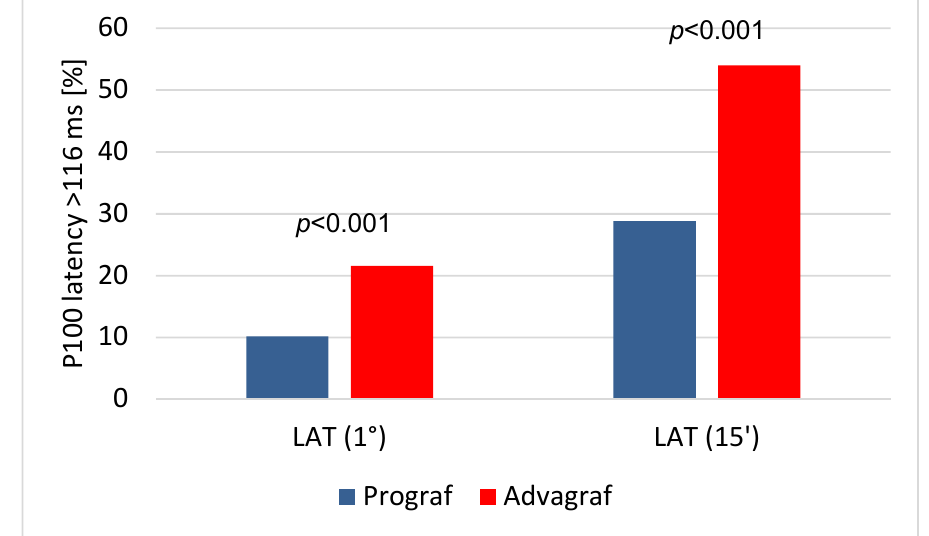
Figure 1. Results of the pattern visual evoked potentials (VEP) examination. The percentage of eyes with prolonged P100 latency (1°) ( A ) and latency (15′) ( B ) duration (with laboratory normal value ≤ 116 ms) in patients treated with Prograf (blue bars) and Advagraf (red bars). Table 2. Results of pattern and flash VEP examinations in the eyes of kidney transplant recipients treated with two different tacrolimus formulations. Prograf Advagraf Statistics n = 59 n = 70 Pattern VEP examination—P100 parameters Latency (1°) (ms) 105.5 (104.2–106.9)